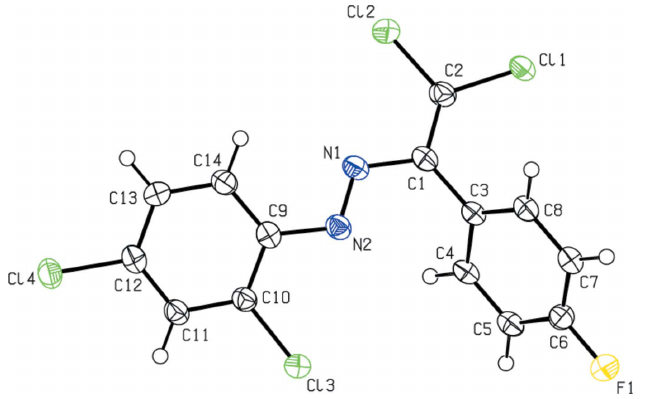
The molecular structure of the title compound, showing the atom labelling and displacement ellipsoids drawn at the 50% probability level.